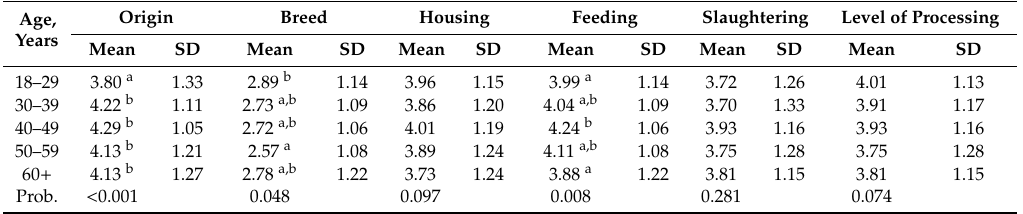
Table 2. E ff ect of production condition and purchase form on buying decision depending on the age (on 1–5 scale). Origin Breed Housing Feeding Slaughtering Level of Processing Age, Years Mean SD Mean SD Mean SD Mean SD Mean SD Mean